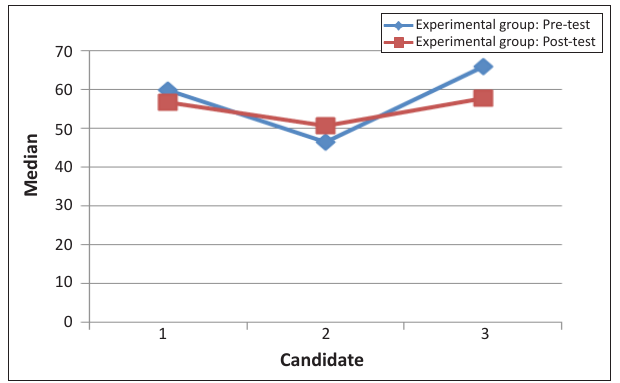
FIGURE 1: The comparison of the pre- and post-test rating for the one-on-one simulation by the experimental group.